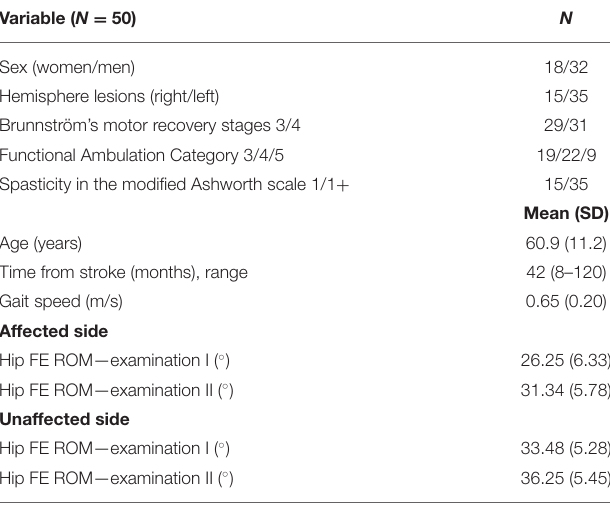
TABLE 1 | Demographic and clinical information about the study